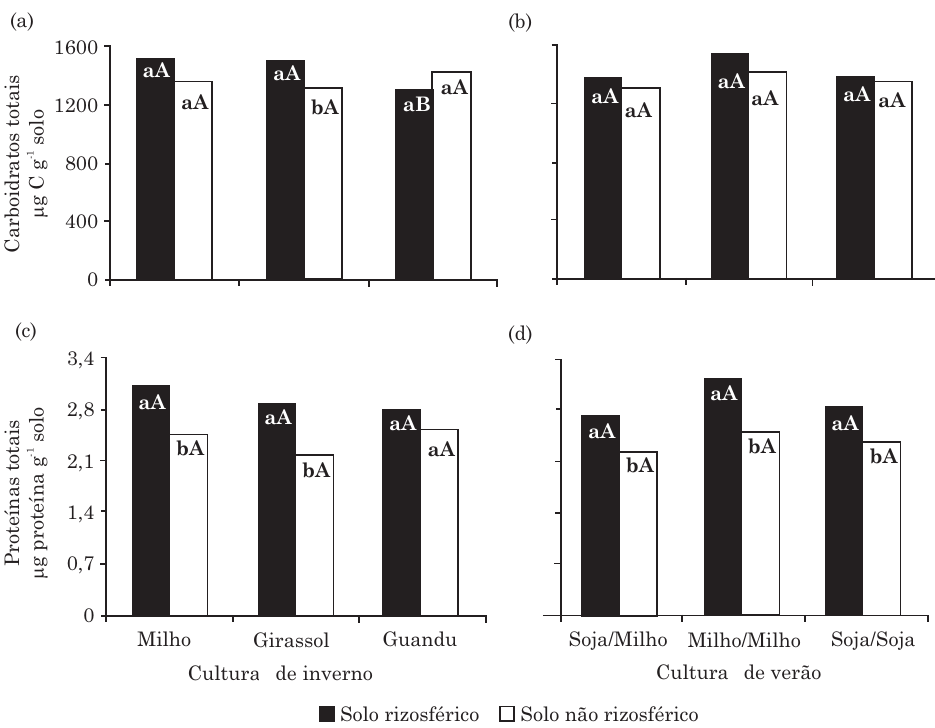
Figura 2. Efeito das culturas de inverno e das sequências de verão em sistema de semeadura direta no teor de carboidratos totais (a, b) e no teor de proteínas totais (c, d) em solo rizosférico e solo não rizosférico. Letras minúsculas iguais (solo rizosférico e não rizosférico) e letras maiúsculas iguais (culturas de inverno ou as sequências de verão) não diferem entre si pelo teste de Tukey a 5